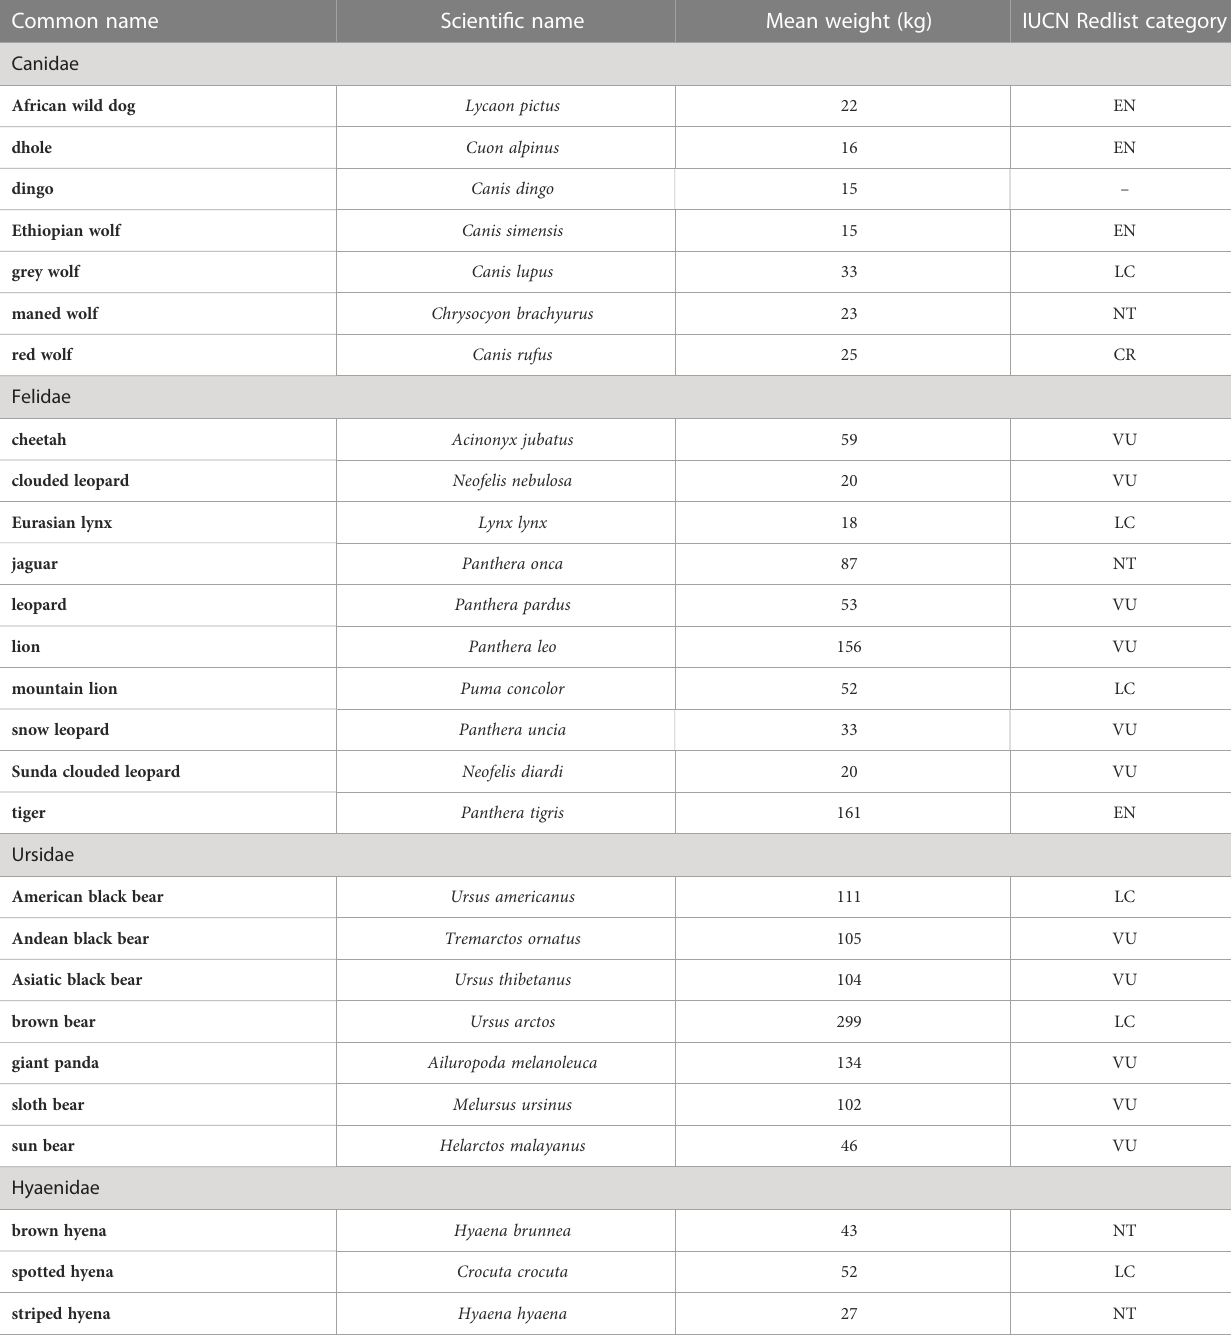
TABLE 1 Terrestrial large carnivore species selected for review. Mean body weight data from Ripple et al. (2016). Conservation status from IUCN Redlist